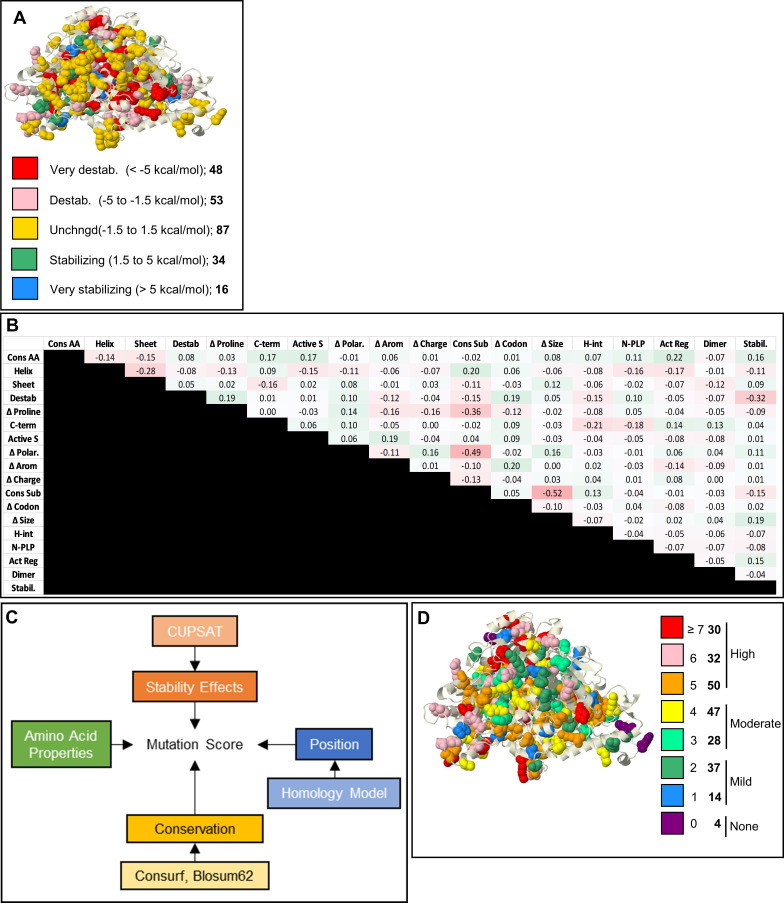
Murine Multiparametric Mutation Score (MMS).[A] Stability effects. CUPSAT-predicted stability effect of NKH mutations on GLDC-protein assessed by ΔΔG for mouse GLDC. For very destabilizing and destabilizing mutations, predicted ΔΔG were <-5.0 and -5.0 to -1.5 kcal/mol respectively. Predicted ΔΔG predicted to be unchanged, stabilizing or very stabilizing are as shown. Number of mutations in each ΔΔG category shown in bold. [B] Phi correlations of 18 parameters predicted to impact protein stability. Most parameters have no correlation with a phi-value of < 0.3. Change in proline, size, and polarity have weak negative correlations with the conservation of amino acid change parameter, indicating that alterations in these amino acid properties are not well-tolerated through evolution. [C] Design for calculating MMS. In total, 18 parameters were used from 4 general categories of stability effects, mutation position, conservation, and change in amino acid properties (see Methods). [D] MMS was calculated for mouse GLDC from a summation of the 18 parameters, each with a weight of 1 except conservation of substitution, which was weighted -1. 3-dimensional distribution of MMS’s shown for all known NKH missense mutations. Key indicates the number of amino acids associated with each MMS range (shown in bold).